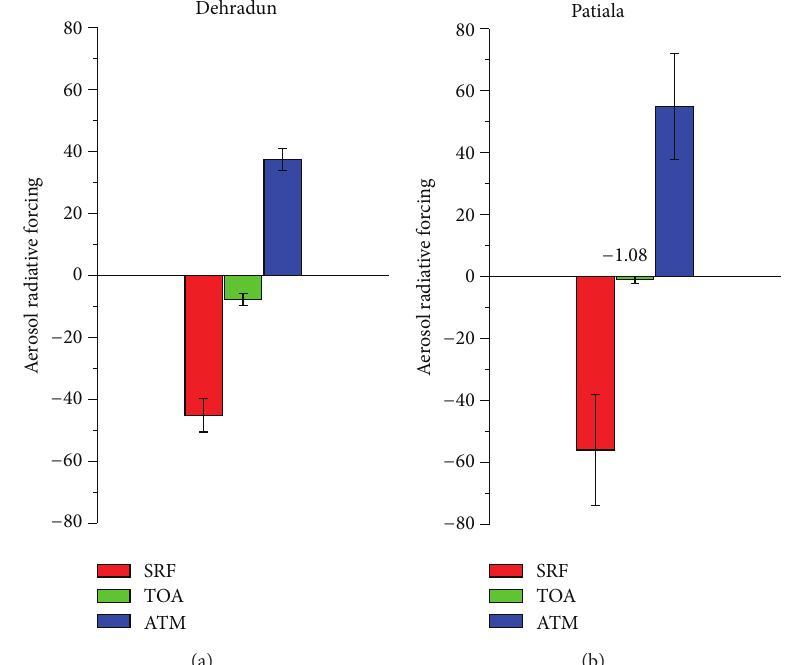
Figure 9: Variation of aerosol radiative forcing at SRF, TOA, and ATM during premonsoon period over Dehradun and Patiala.